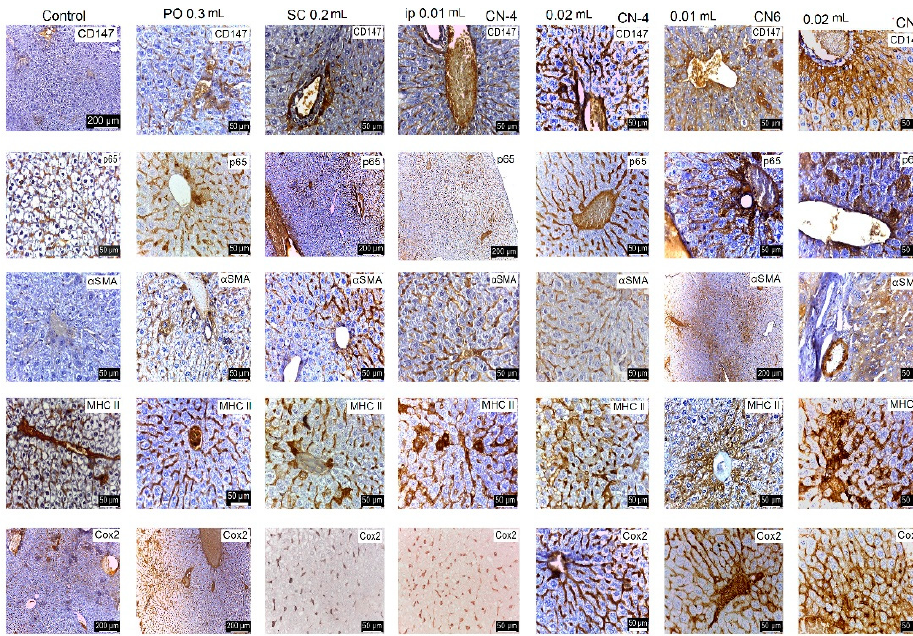
Figure 15. IHC marking in the liver.